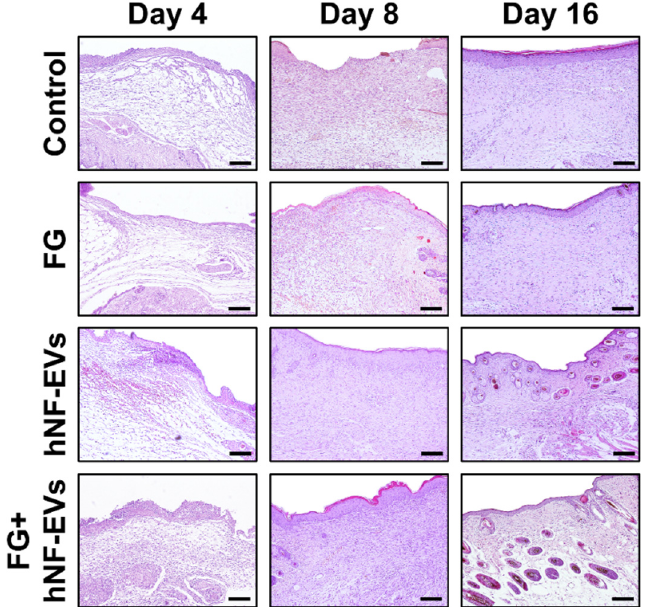
Figure 7. hNF-EVs promoted skin density. H&E staining of wound sections in control: FG, hNF-EV, and FG + hNF-EV groups (day 4, 8, and 16; scale bar = 100 µm).